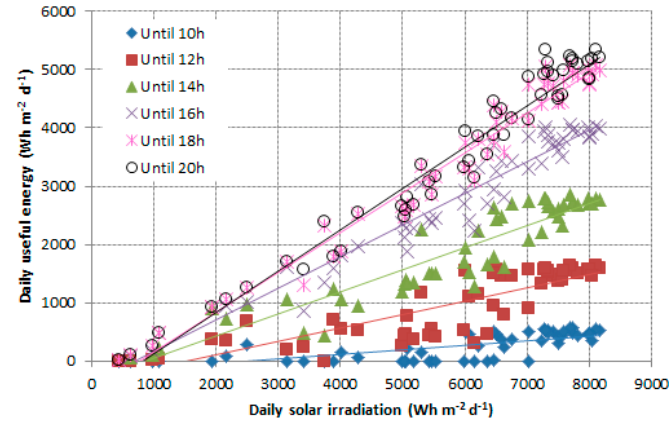
Figure 3. Daily energy delivered to the tank with irradiation, for different times of day.